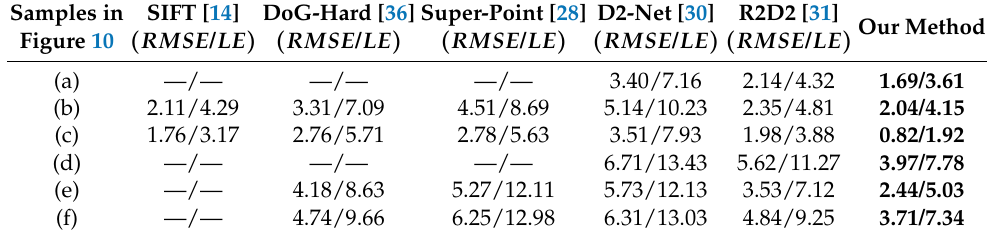
Table 5. The RMSE (in pixel) and localization error (in meters) results on the six sample image pairs. The SIFT and deep compare cannot finish this experiment; thus, their results are not displayed here.